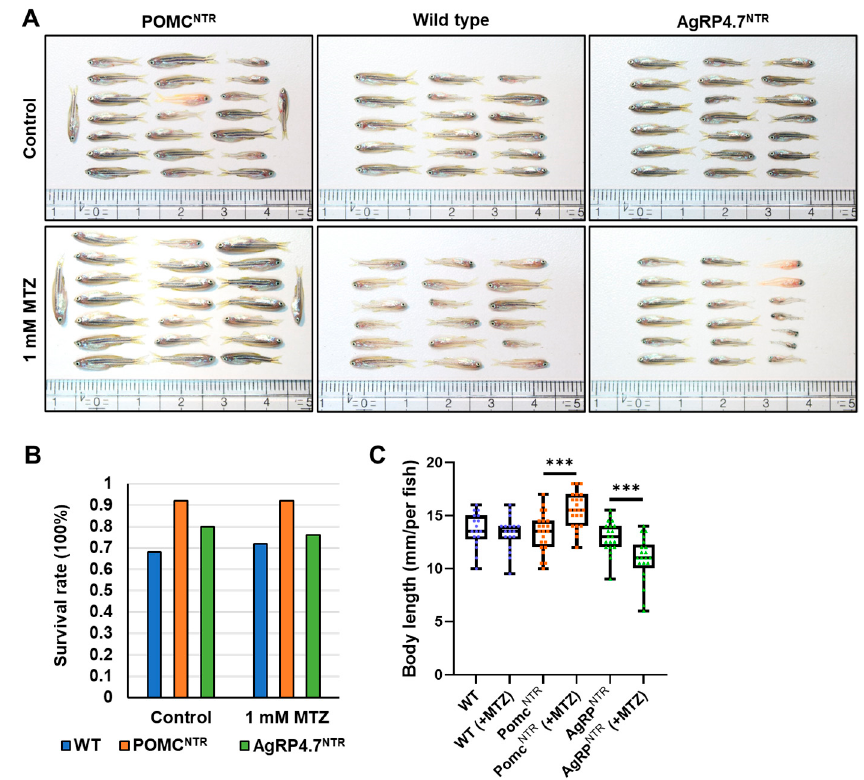
Figure 4. Blind test experiment of targeted neuron ablation transgenic fish. ( A ) Lateral views of POMC NTR , WT, and AgRP4.7 NTR six-week-old larvae. ( B ) Survival rate of each group. ( C ) Statistical analysis of body length (jaw to caudal fin) in six-week-old POMC NTR , WT, and AgRP4.7 NTR larvae. Data are shown as box plots including median (line), interquartile range (box), and 95% confidence interval (whiskers). *** p < 0.001.